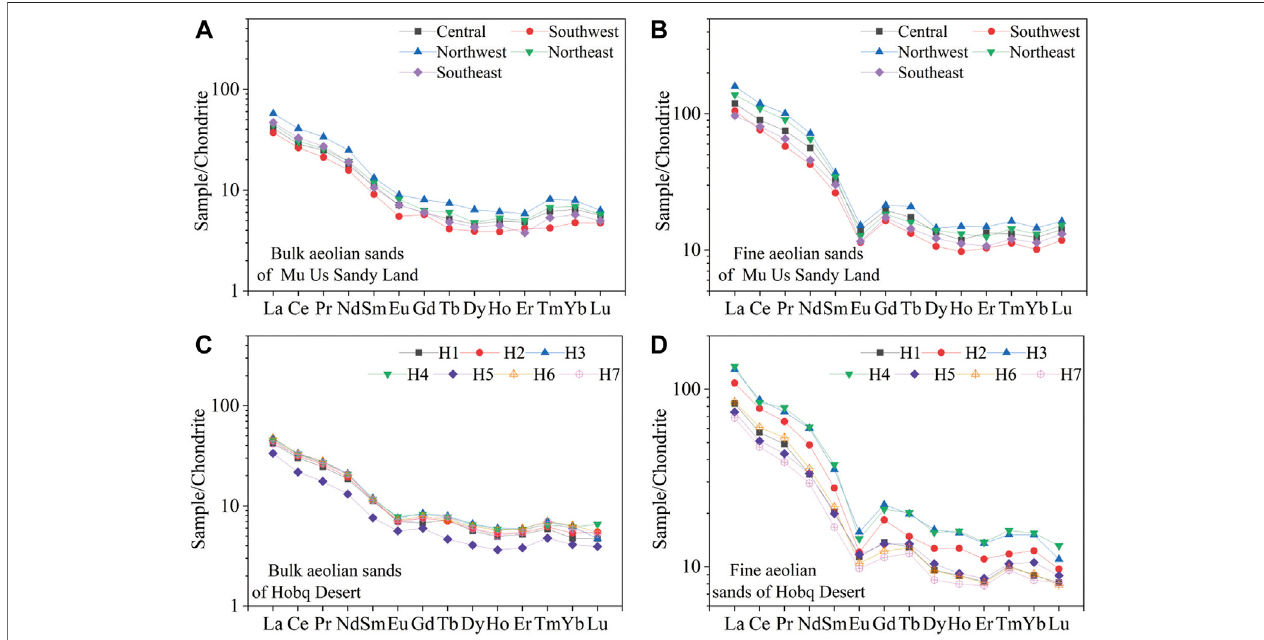
FIGURE6| Chondrite-normalizedREEpatternsfordifferentfractions. (A,B) areforbulkand fi nefractionsandsintheMuUsSandyLand,respectively. (C,D) arefor bulk and fi ne fraction sands in the Hobq Desert, respectively. UCC values from Taylor and McLennan (1985).